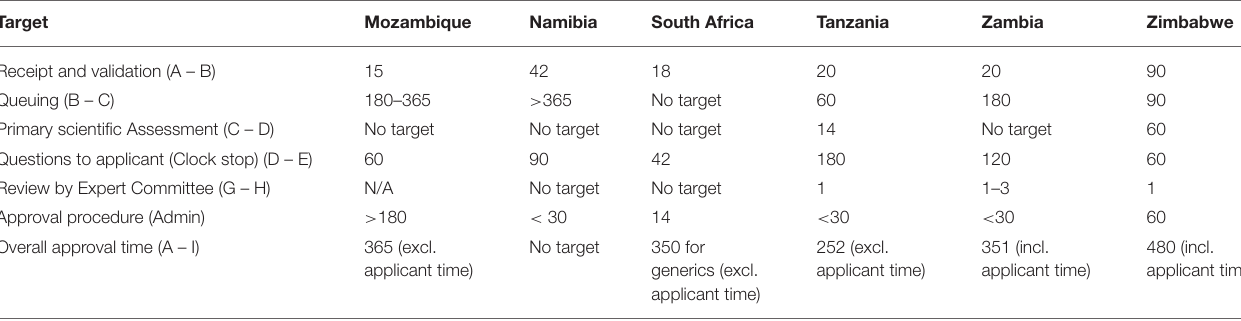
TABLE 6 | Comparison of targets for key milestones in the full (type 3) review process -(calendar days).